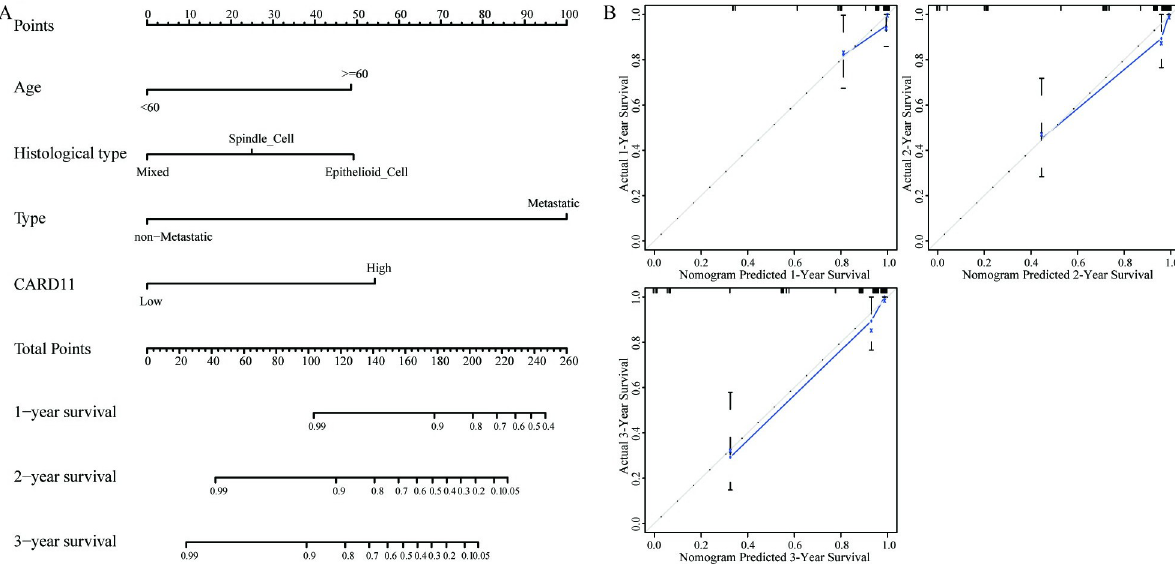
Fig 5. Nomogram construction for survival prediction. ( A ) Nomogram construction combined CARD11 expression with clinicopathological features to predict the OS of patients. ( B ) Calibration curve of Nomogram; the Abscissa is the survival predicted through the nomogram, and the ordinate is the actual observations, repeating 1000 times each time. The curve showed that the nomogram predicted the 1-, 2-, and 3-year OS in UVM patients effectively.